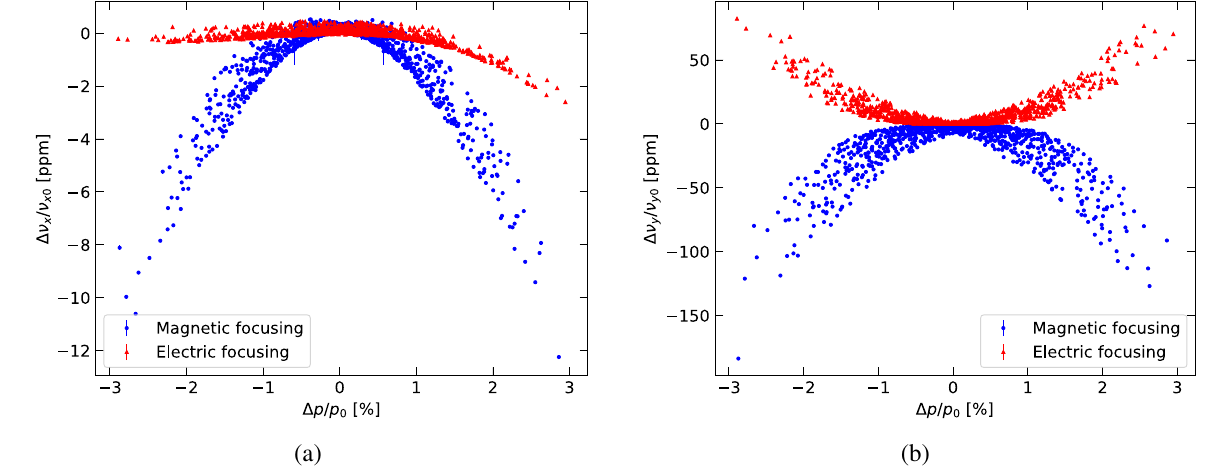
FIG. 3. The relative differences of the transverse betatron tunes between numerical and analytic estimations. The analytic estimations were obtained to the first order of the normalized momentum offset δ . Details of the simulation setup and parameters are described in the =v text. (a) Relative difference of the horizontal tune ð Δ v as a function of the fractional momentum offset. (b) Relative difference of x x 0 Þ =v the vertical tune ð Δ v as a function of the fractional momentum y y 0 Þ